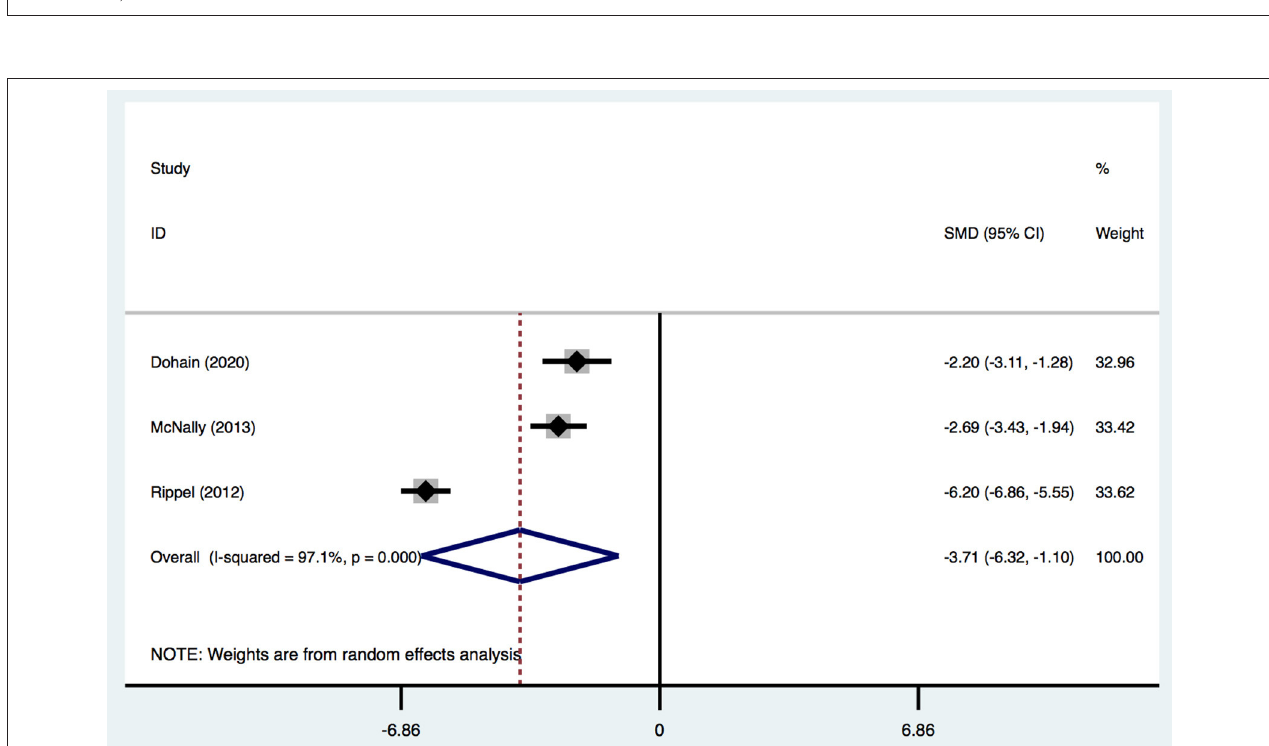
FIGURE 6 | Forest plot for the relationship between VitD level and maximum VIS in the meta-analysis of three trials using random-effect model. Only the first author of each study is given. Test for overall effect, z = 2.78, P = 0.005; test for heterogeneity, I 2 = 97.1%, P = 0.000. SMD, standard mean difference. CI, confidence interval.